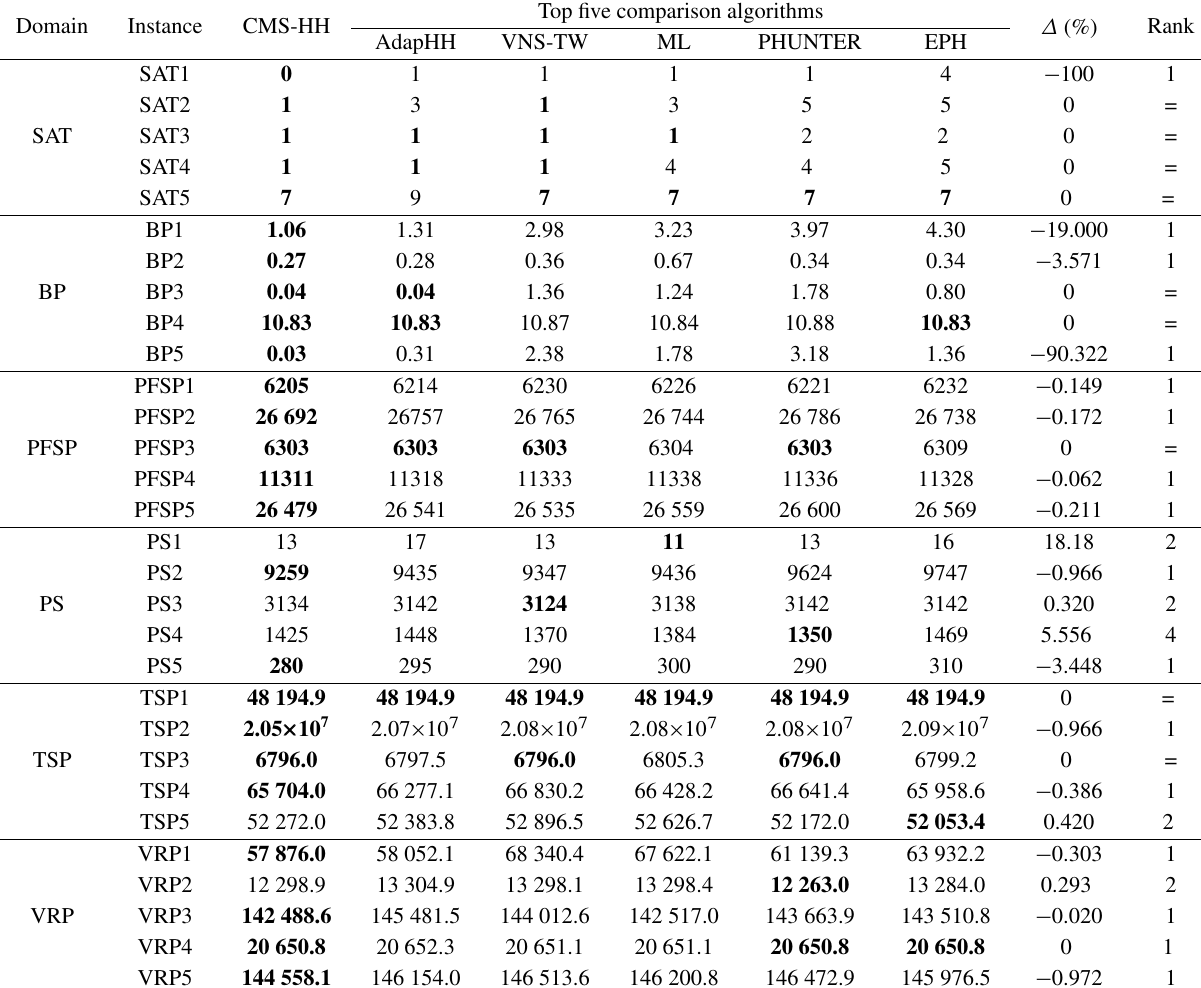
Table 11 Performance comparison of CMS-HH and the top-five comparison algorithms based on the minimum objective values over 31 trials in different instances from six diverse problem